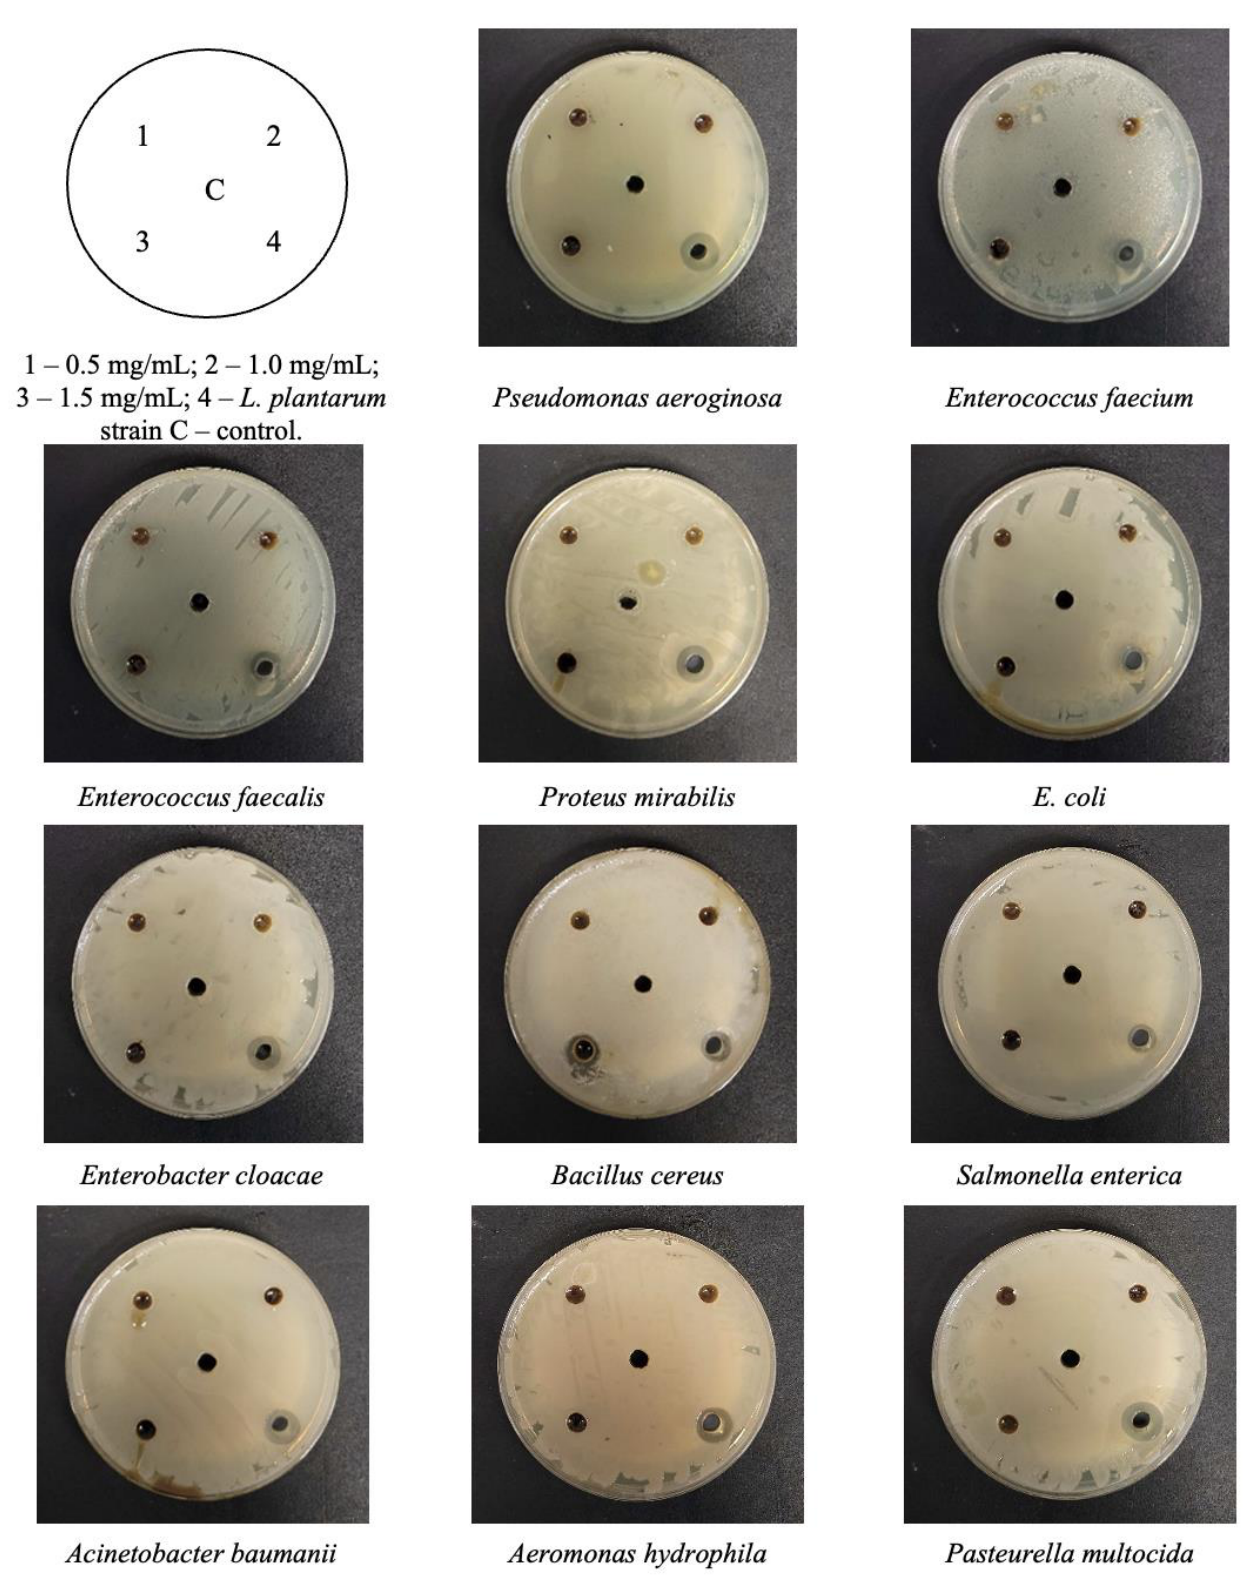
Figure 1. Images showing the diameters of inhibition zones (DIZ) by pine extract and L. plantarum strain against the tested pathogens.